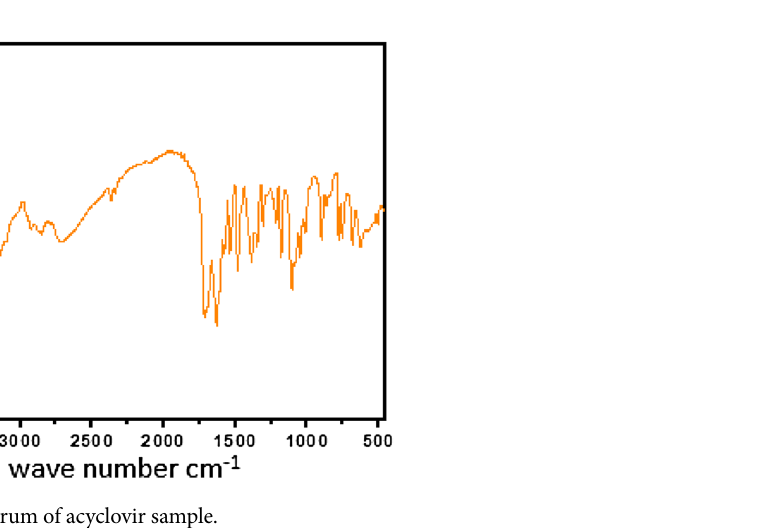
Figure 7. FTIR spectrum of acyclovir